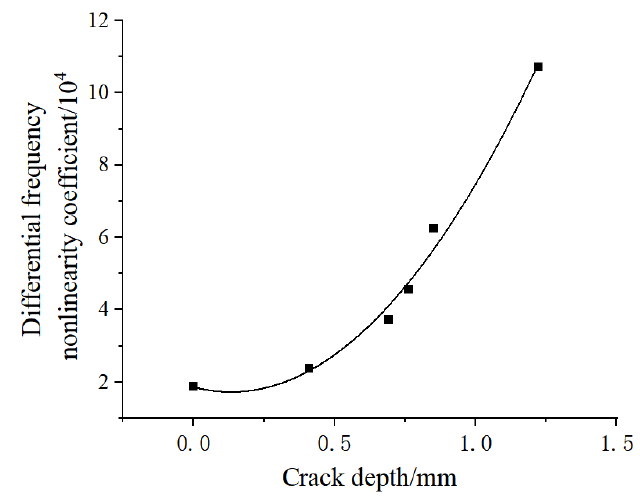
Figure 13. Relation between differential frequency and crack depth.